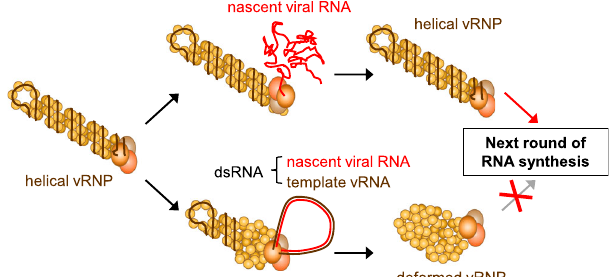
Fig. 7 Model for synthesis of nascent viral RNAs by in fl uenza vRNPs. When folded viral RNA is synthesized, the vRNP keeps its helical rod- shaped structure and the vRNP is used in next round of RNA synthesis (upper). In contrast, when looped dsRNA is produced, the vRNP disrupts its helical rod-shaped structure because it loses the residential vRNA. As a result, such deformed vRNP cannot proceed to the next round of RNA- synthesis cycle